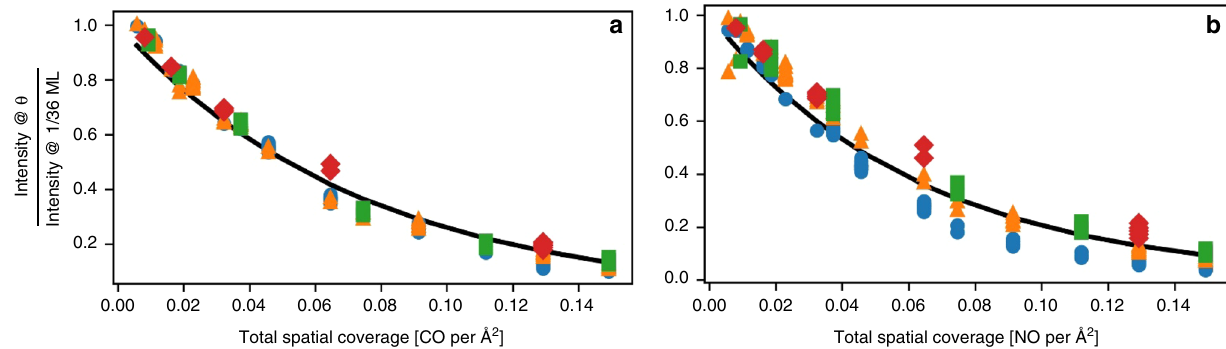
Fig. 5 Intensity-coverage scaling factors (CSF I ). Referenced to 1/36ML coverage for the ( a ) C – O stretch and ( b ) N – O stretch modes vs. coverage. Calculations are for extended Pt surfaces with either adsorbed CO ( a ) or NO ( b ). Data for atop sites (blue circles), bridge sites (green squares), threefold sites (yellow triangles), and fourfold sites (red diamonds) all fall on the same curve. Also shown is the exponential fi t of CSF I to total spatial coverage ( θ T ). R 2 values are 0.97 and 0.92 for the fi ts to CO and NO,